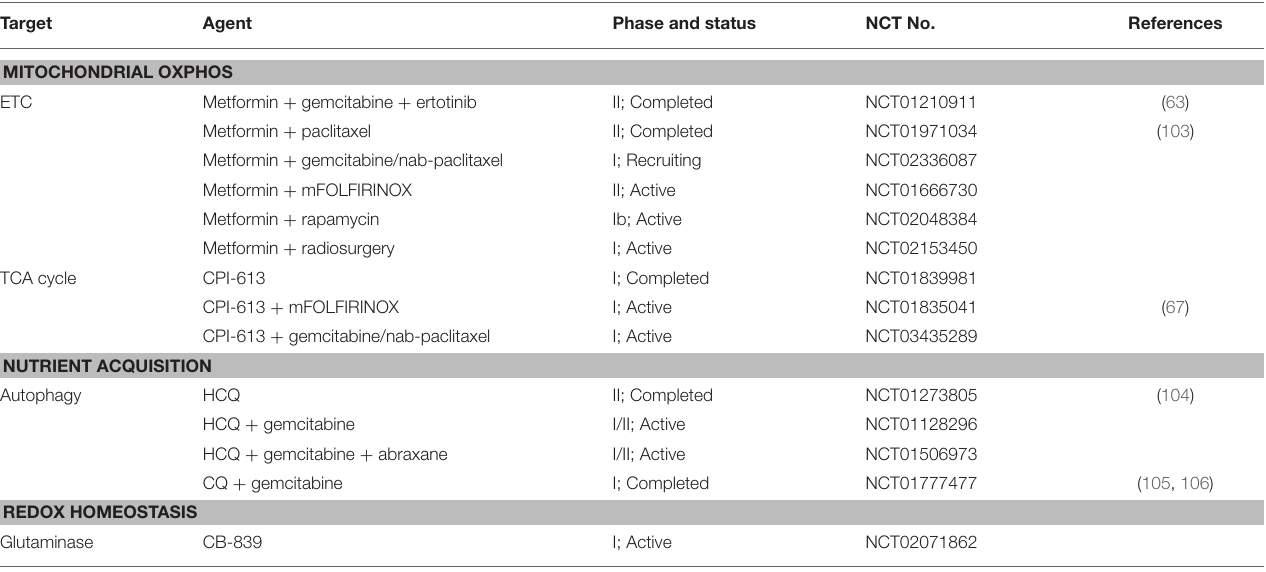
TABLE 2 | Clinical trials targeting key steps of PDA